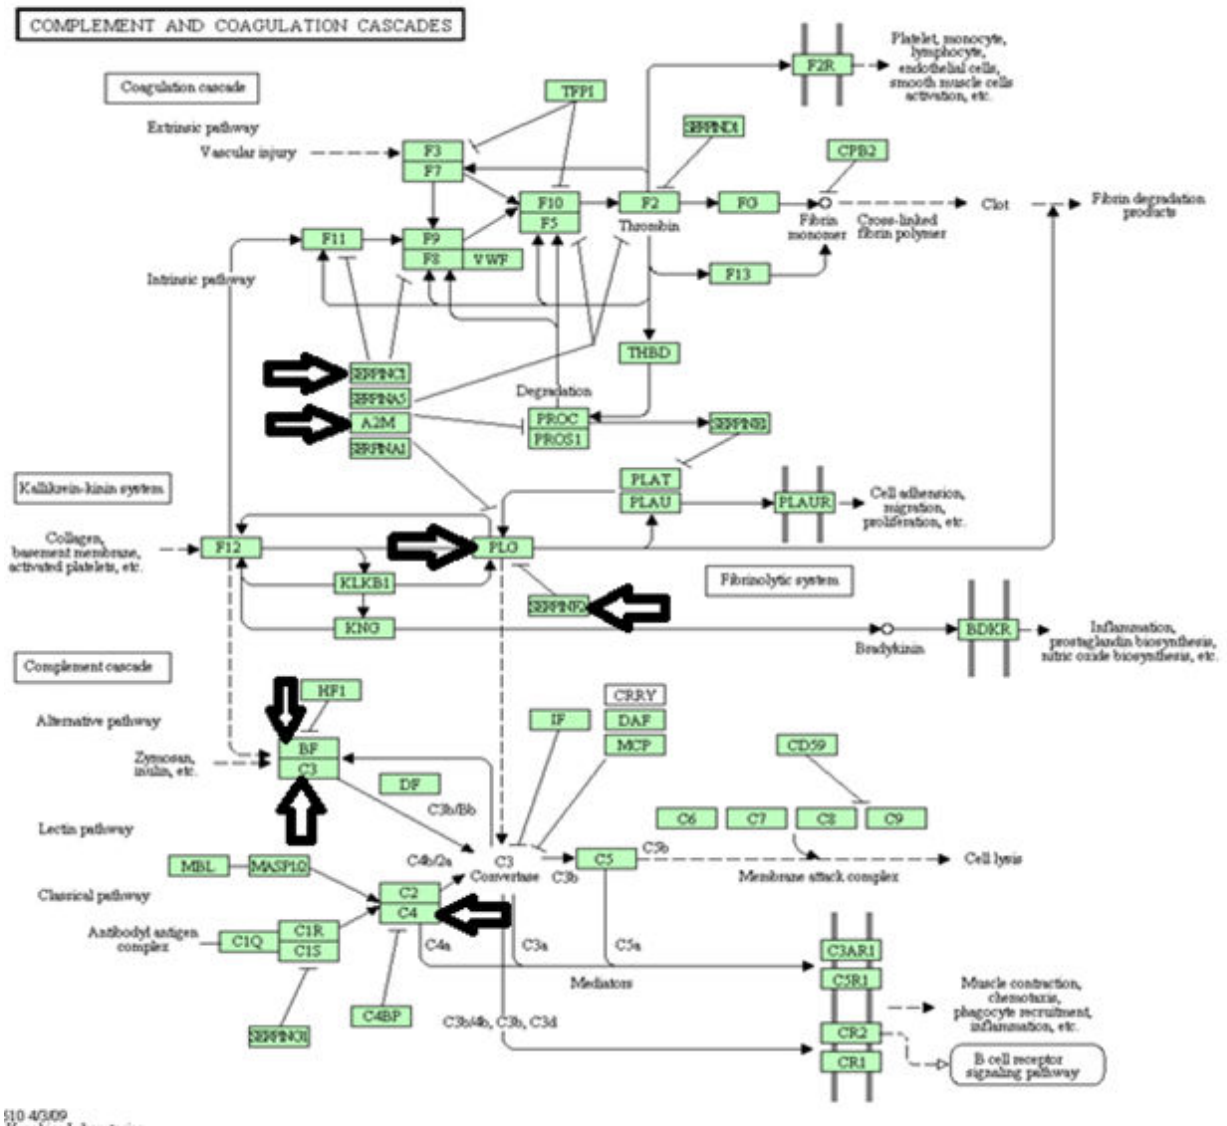
Figure 5. Complement-coagulation pathway from KEGG database [57,58]. The proteins over-represented in our data set are marked by an